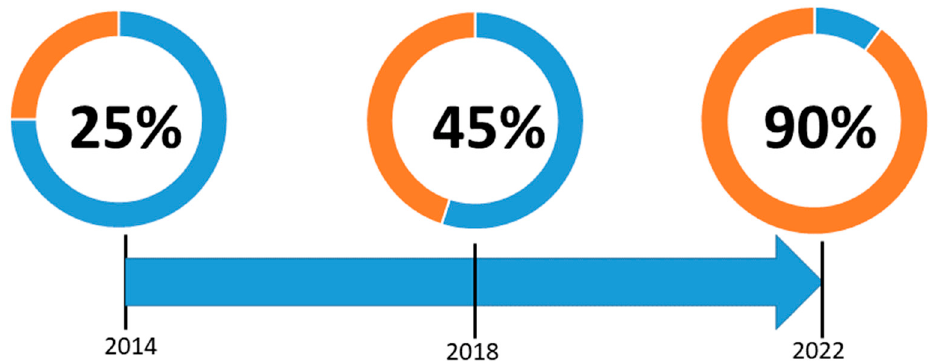
Figure 3. Time evolution in the percentage of HERCA countries having NRAPs in place. At 2014: year of approval of directive 2013/59/Euratom (EU-BSS) and first HERCA Workshop on NRAPs; 2018: deadline for the transposition of the EU-BSS; and 2022: by February, when the last review was conducted.